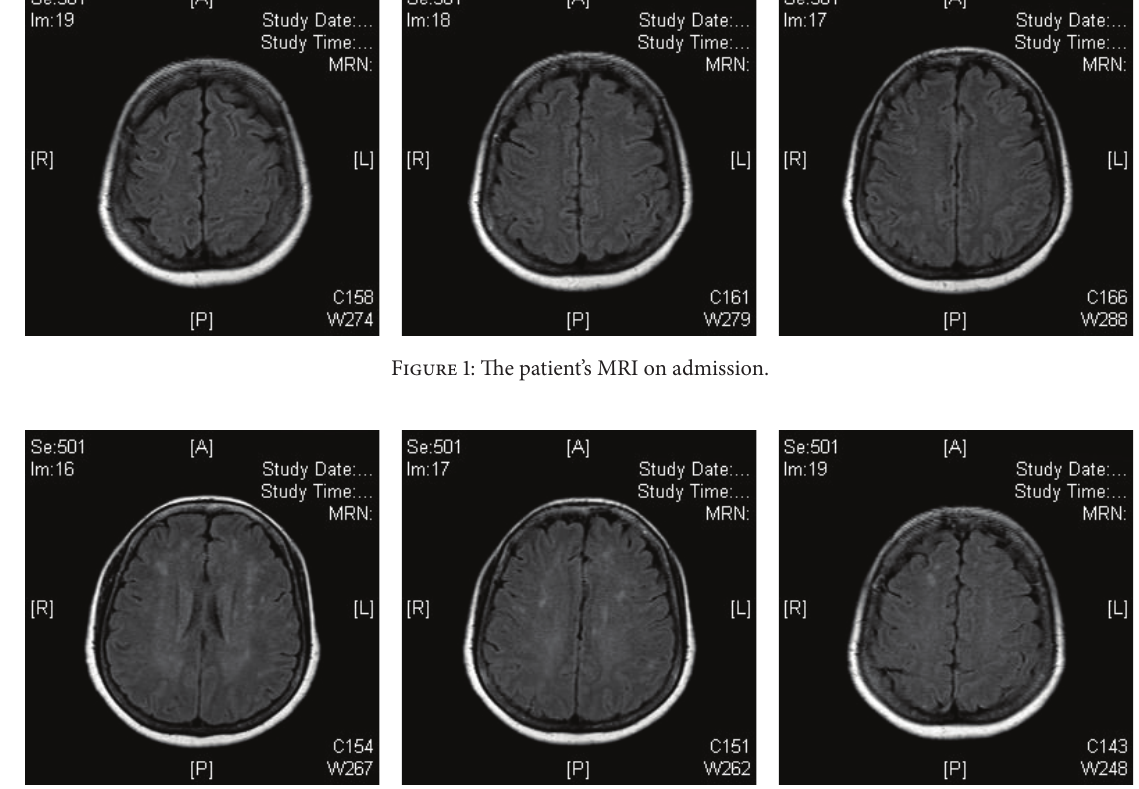
Figure 2: The patient’s MRI performed two weeks later, which demonstrates white matter